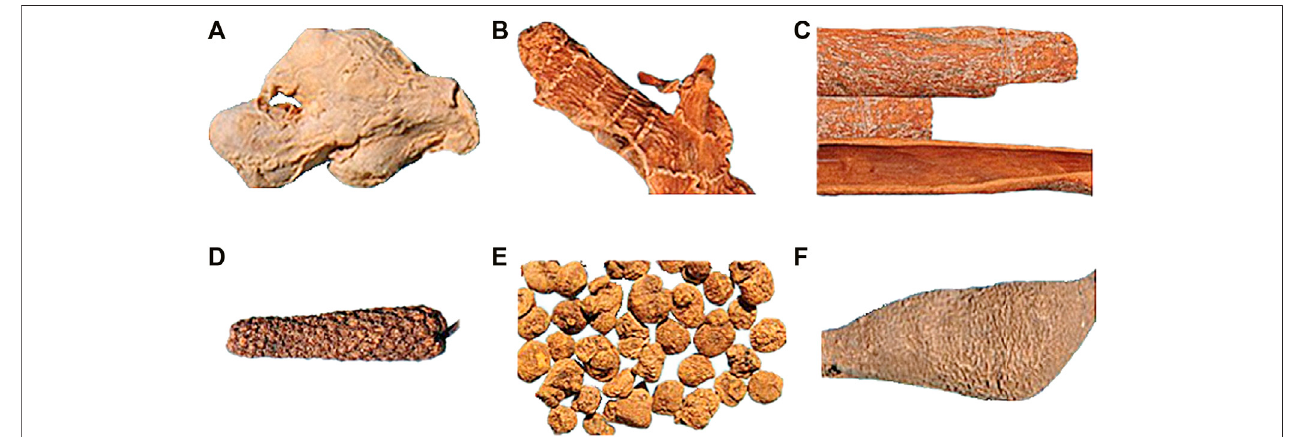
FIGURE1| Exampleof6herbs ofYuanjiang decoction. (A) , Zingiberis rhizoma ; (B) , Alpiniae of fi cinarum rhizoma ; (C) , Cinnamomi cortex ; (D) , Piperislongifructus ; (E) , Corydalis rhizoma ; (F) , Curcumae radix